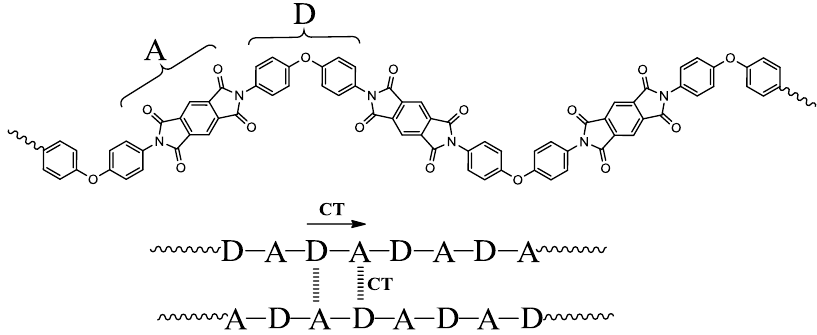
Figure 4. Chain sequence of wholly aromatic PIs (PMDA/4,4′-ODA system is shown here as an example) and intra- and intermolecular CT interactions. D and A represent electron-donating and electron-accepting units, respectively.